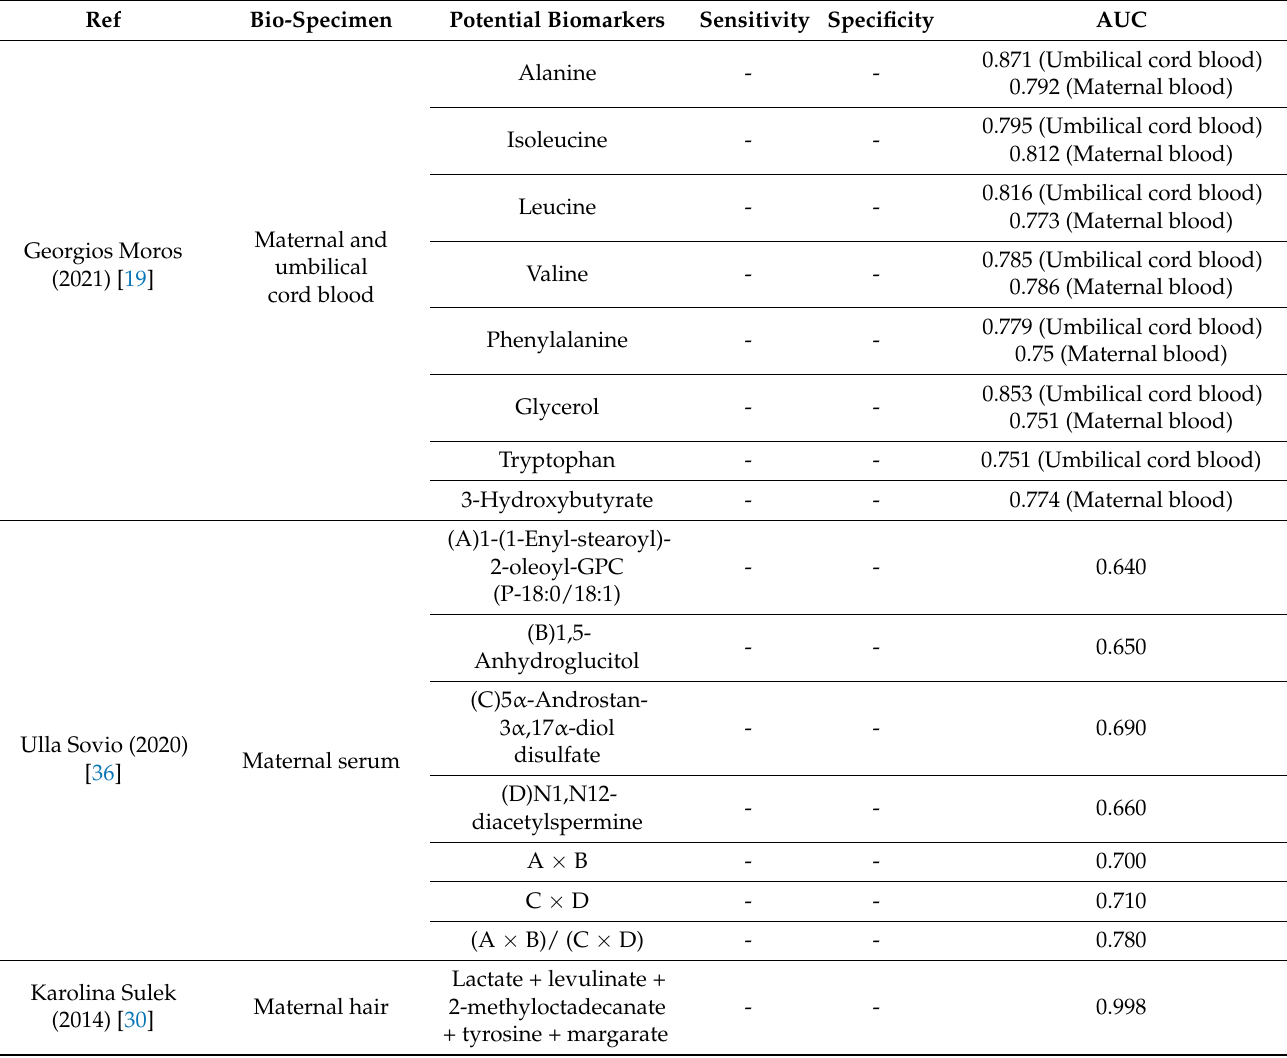
Table 4. The Potential of Metabolic Markers for the Prediction and Diagnosis of